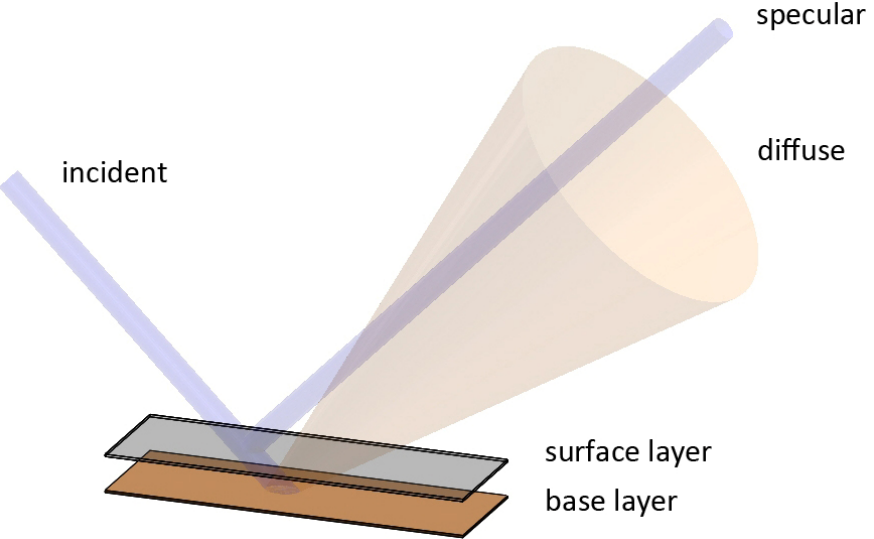
Figure 3. The reflection of terahertz beam on “idealized” multilayer structure model.